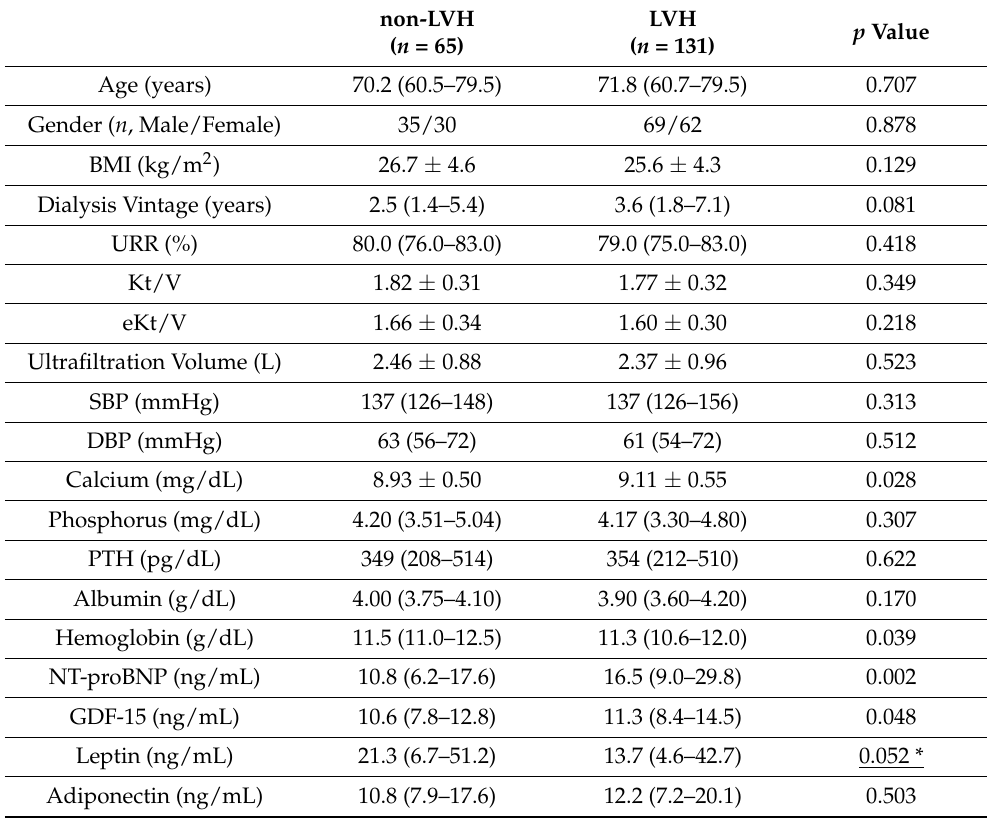
Table 1. Demographic, dialysis-related and biochemical data for end-stage renal disease patients without and with left ventricular